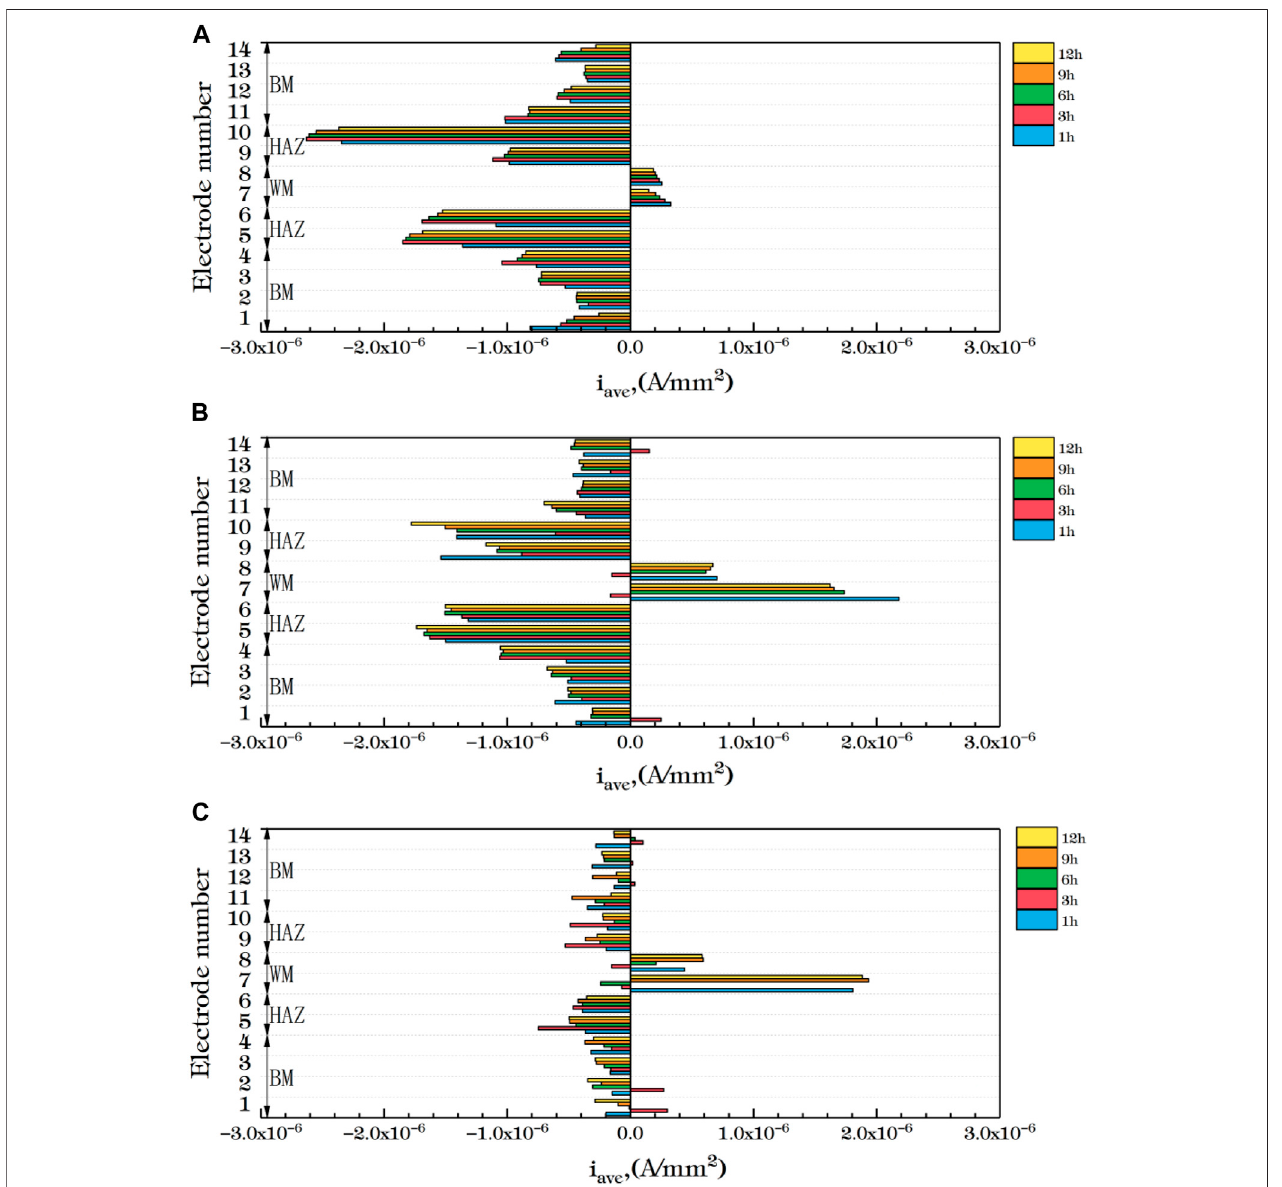
FIGURE 10 | Average current density distribution of each row of welded joints at different temperatures (A) 25 ° C (B) 35 ° C (C) 45 ° C.